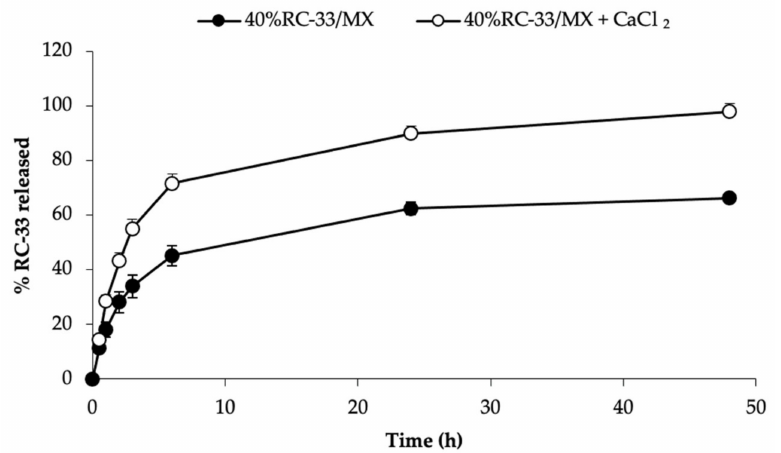
Figure 11. RC-33 release profiles of freeze-dried matrices loaded with RC-33 amounts corresponding to 40% of the GG interaction sites in absence (40%RC-33/MX) and in presence of CaCl 2 (40%RC- 33/MX + CaCl 2 ) (mean values ± s.e.; n =